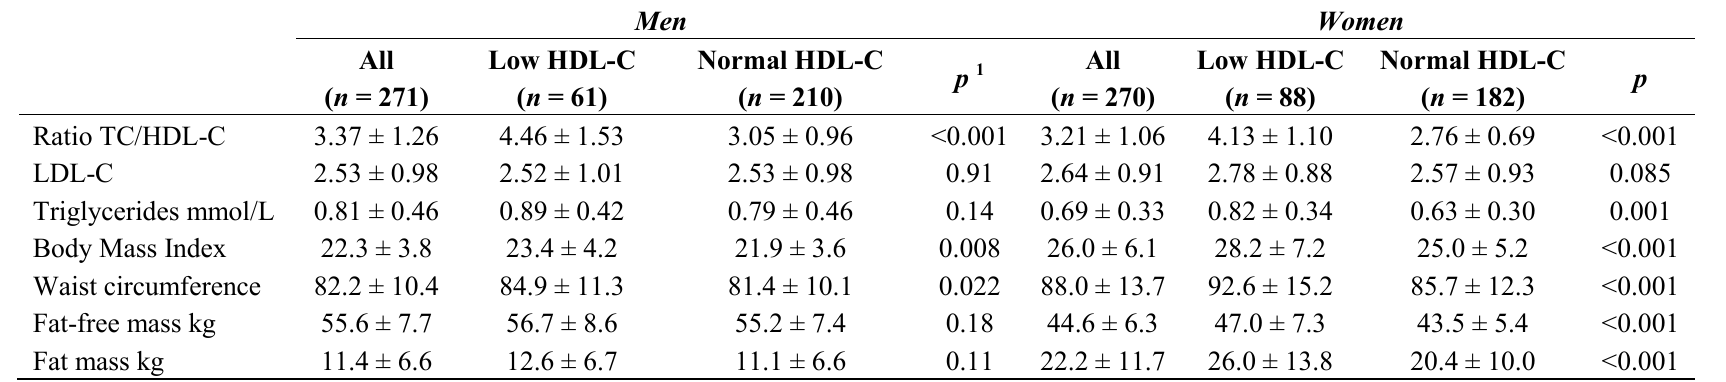
Table 2. Serum lipid and body composition according to HDL-C level. LDL-C, low- density lipoprotein cholesterol.